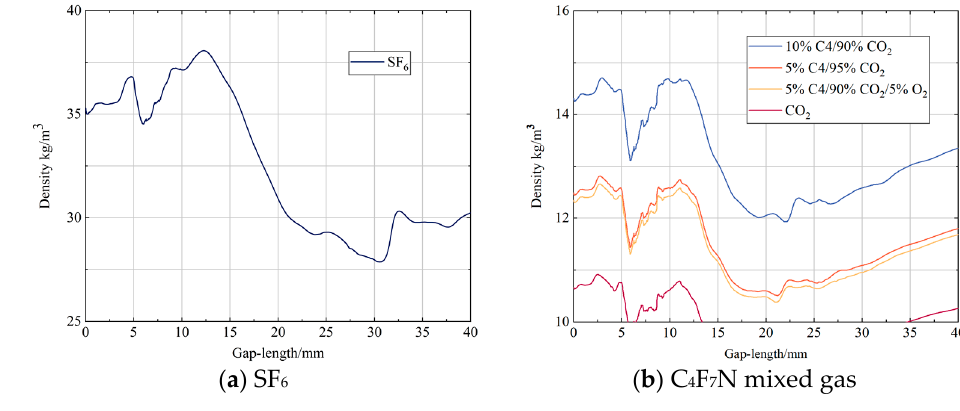
Figure 8. Curve of minimum density with gap length.